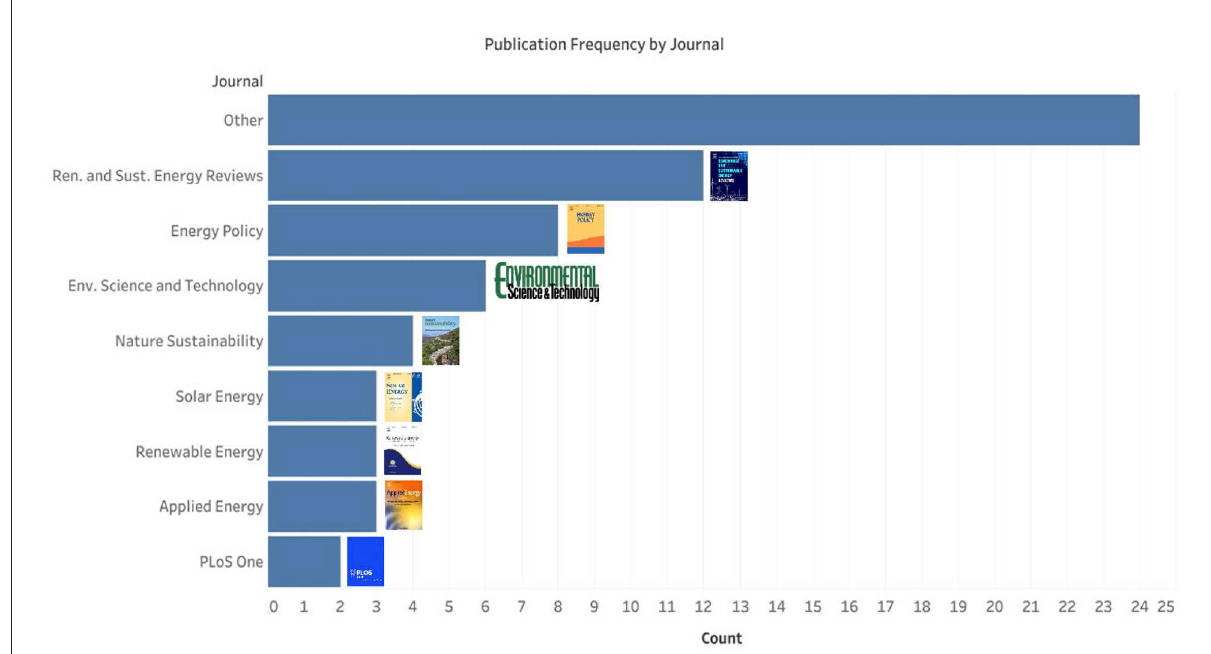
FIGURE4 Number of articles ( n = 66) published in journals (total unique journals = 33) identified in the SCOPUS database as of February 26th, 2020 that met inclusion criteria for this study. The category of “Other” represents number of individual journals in which one journal article reported solar energy-land relationship metrics, specifically a term and a unit, in an